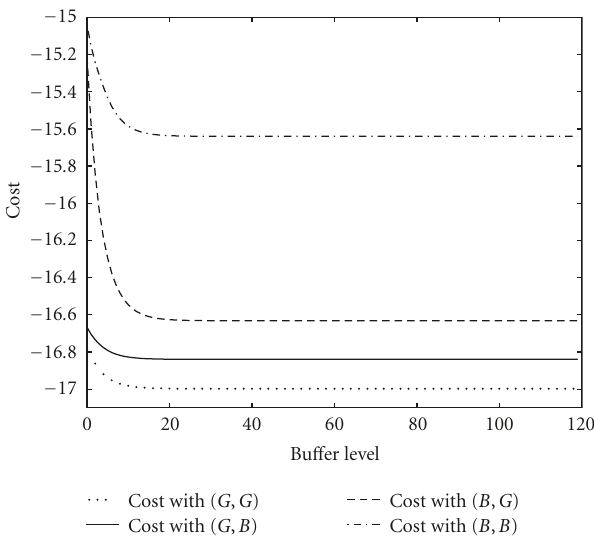
Figure 4: The optimal cost as a function of the initial bu ff er state with di ff erent combinations of initial channel